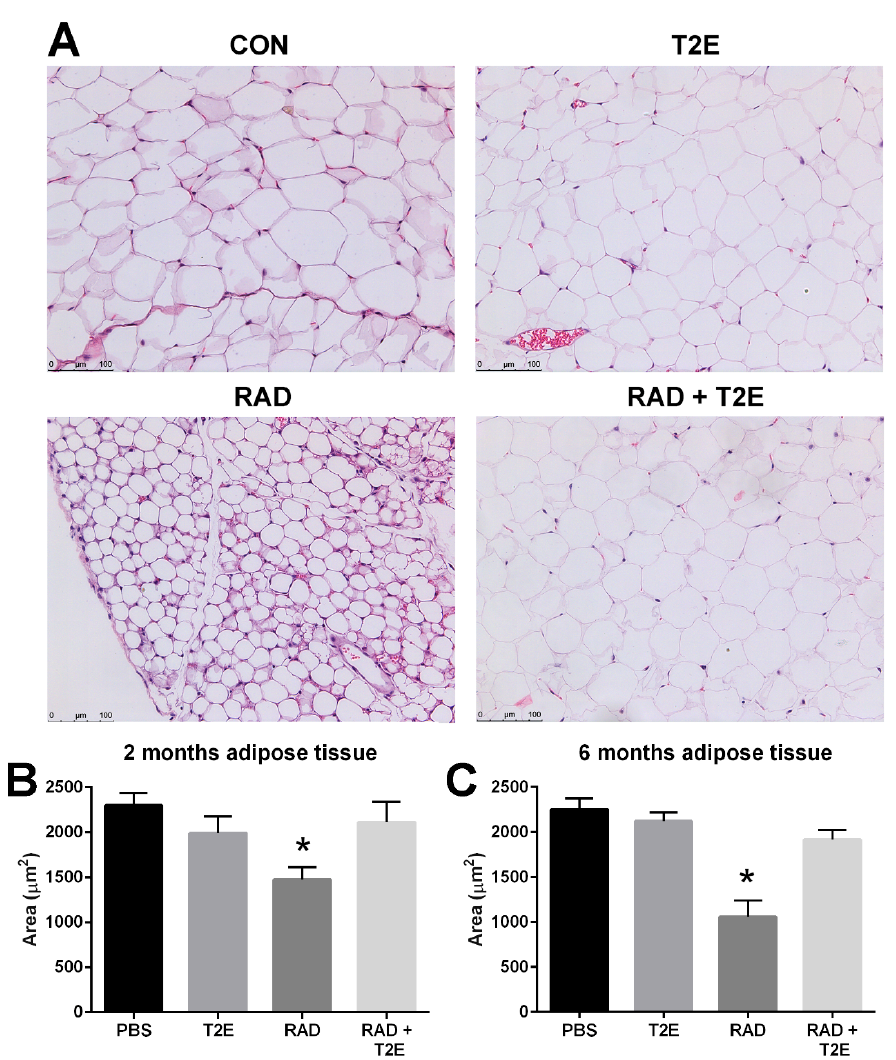
Figure 9. MnTE-2-PyP treatment reverses radiation-induced reduction of adipocyte size at 2 and 6 months post-irradiation. ( A ). Representative sections of adipose tissues at 6 month post-irradiation stained with hematoxylin and eosin to observe adipocyte cell size in each of the four groups: Control for adipocyte cells in each group at 2 months post-irradiation. ( C ). The average area for